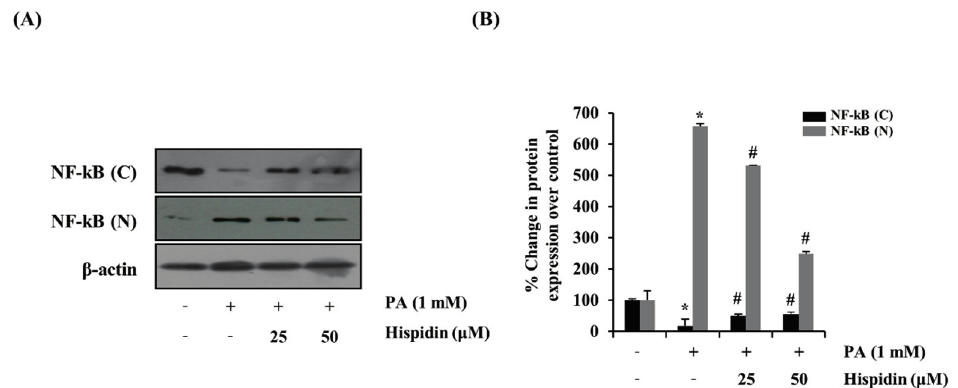
Figure 5. Effect of hispidin on the translocation of NF- κ B in palmitate-treated C2C12 myotubes. C2C12 myotubes were cultured with indicated concentration of hispidin for 8 h, and then exposed to 1 mM palmitate for 16 h. ( A ) The expression levels of fractional NF- κ B were assessed using western blot analysis. ( B ) Quantitative analysis of the band density of fractional NF- κ B. The equal loading of the total proteins in each sample was confirmed by the expression of β -actin. Data represent the mean ± standard error of three independent experiments. * p < 0.05, as compared with only BSA group, # p < 0.05, as compared with PA group. NF- κ B (N), nuclear fraction of nuclear factor- κ B; NF- κ B (C), cytosolic fraction of nuclear factor- κ